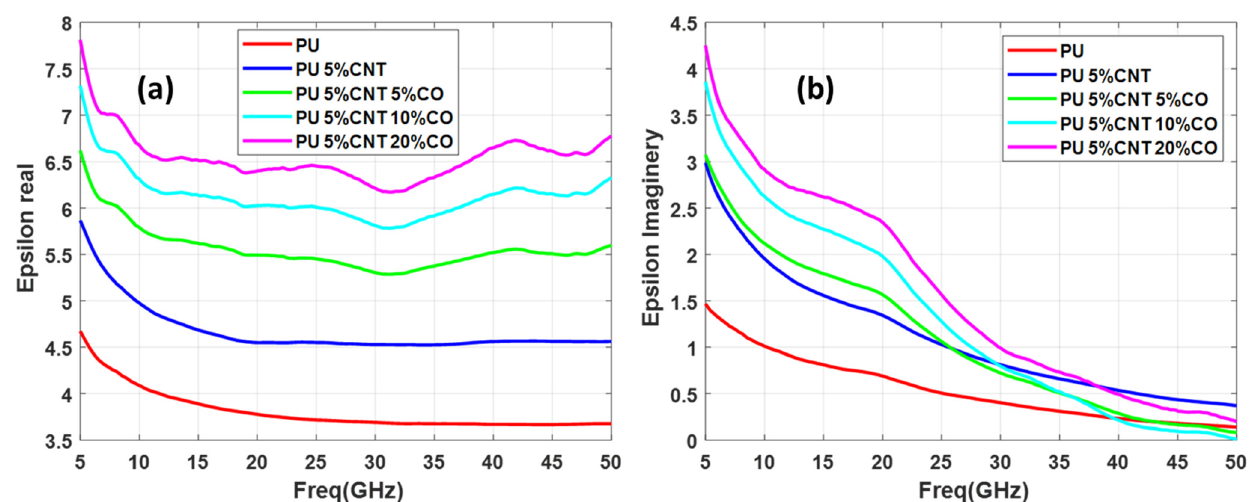
Figure 7. Permittivity of PU + 5%CNT with different concentrations of Co: ( a ) real part, ( b ) imaginary part.